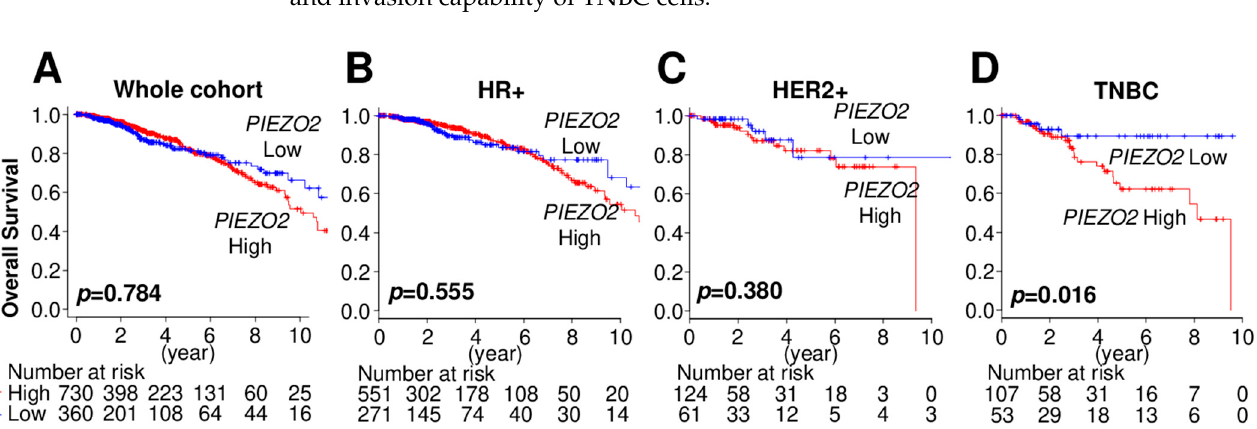
Figure 1. Increased PIEZO2 expression is associated with poor clinical outcomes in patients with TNBC. ( A ) Breast cancer prognosis by PIEZO2 expression in the whole cohort, ( B ) hormone receptor-positive (HR+), ( C ) HER2-positive (HER2+), and ( D ) triple-negative breast cancer (TNBC) of TCGA cohort. Red line represents PIEZO2 high tumors and blue line represent PIEZO2 low tumors.